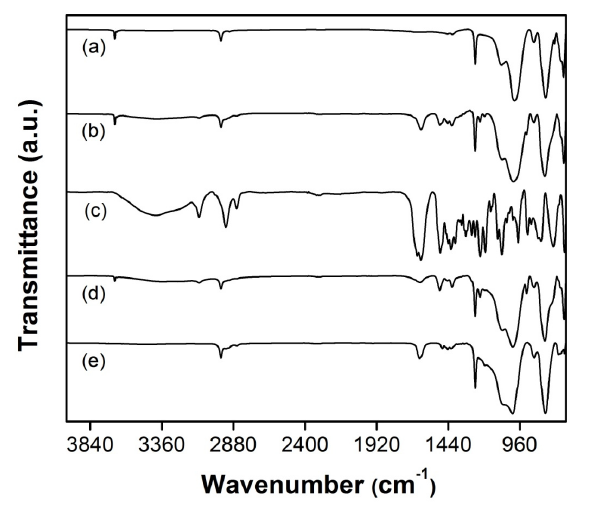
Figure 4. FTIR-ATR spectra for SR ( a ), SR-g-(NVCL-co-NVIM) 75% graft ( b ), poly(NVCL-co-NVIM) ( c ), SR-g-NVIM 106% graft ( d ), and SR-g-NVCL 29% graft ( e ).